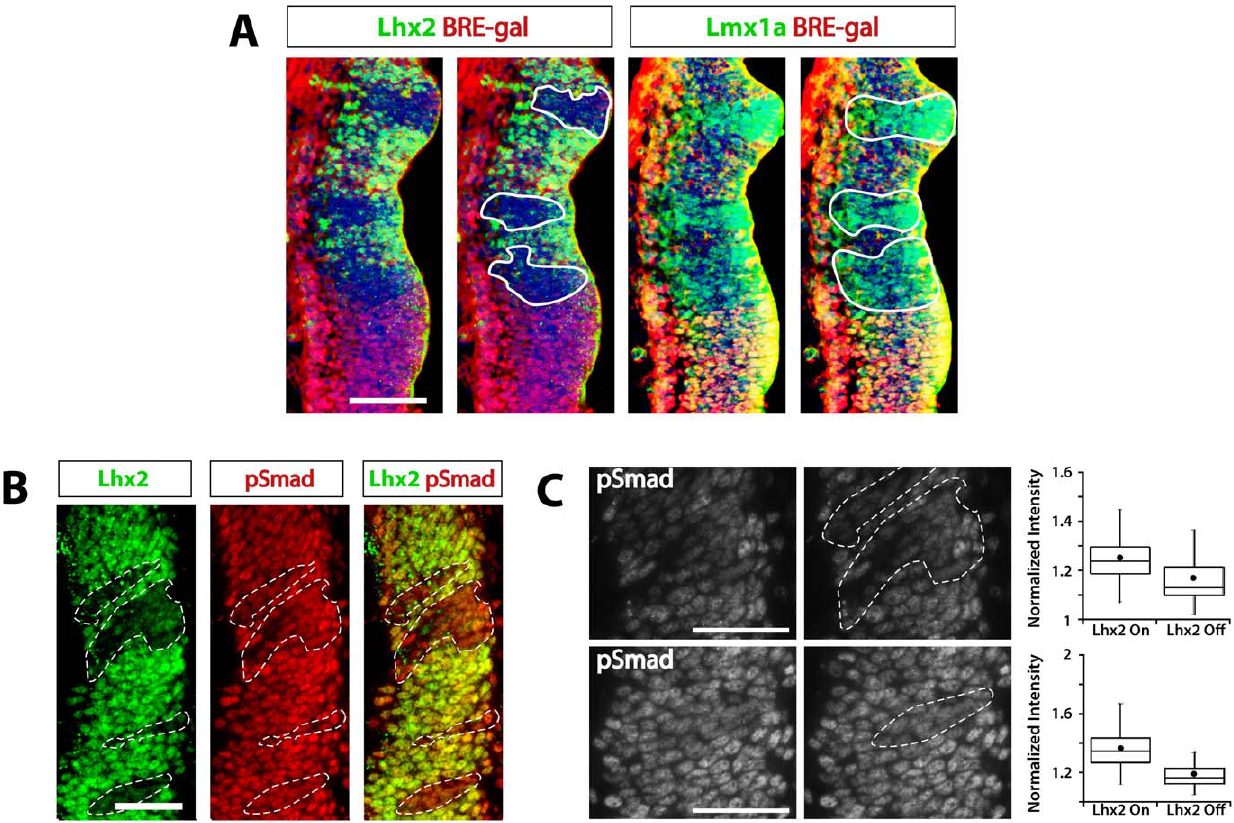
Figure 5. Absence of BRE-gal or increased pSmad levels in ectopic hem cells. IHC of coronal sections from E12.5 Lhx2 null chimeras, confocal images. ( A ) The normal hem (towards bottom of panels) expresses BRE-gal and Lmx1a, but not Lhx2. Lhx2 null patches (white lines) seen in adjacent sections of the medial pallium upregulate Lmx1a, but do not express BRE-gal. Scale bar: 100 um. ( B ) pSmad levels (red) are not elevated in Lhx2 null patches in the medial pallium (white dashed lines). Scale bar: 50 um. ( C ) Monochrome pSmad images shown in (B) and boxplots of their relative pSmad intensities (normalized to Hoechst intensity). pSmad intensity is lower in ‘‘Lhx2-off’’ (Lhx2 null) hem cells compared to adjacent ‘‘Lhx2- on’’ medial pallial progenitors (p , 0.0001 for both sections). Non-normalized pSmad intensity values were also statistically significant (p=0.007 for patches away from endogenous hem (top of panel), p=0.0001 for patches closer to hem (bottom of panel)). Scale bar: 50 um.